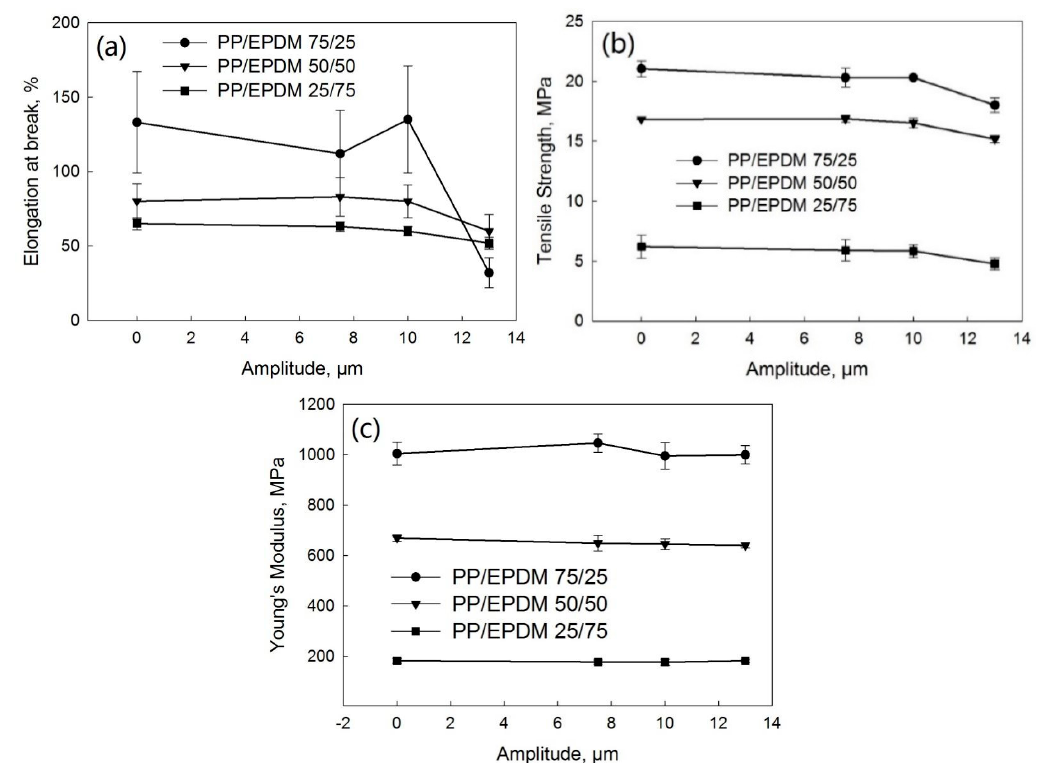
Figure 11. Elongation at break ( a ), tensile strength ( b ), and Young’s modulus ( c ) as a function of the ultrasonic amplitude for various ratios of the PP/EPDM blends prepared by the OS method.